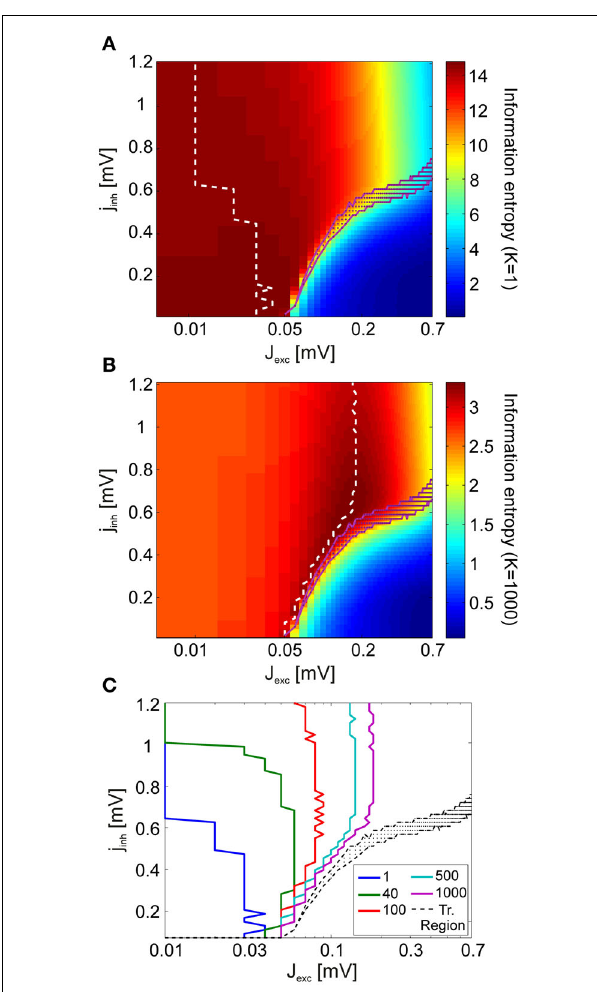
FIGURE 7 | Analysis of information entropy in V4 spike patterns. Information entropy in coupling space for the finest observation scale ( K = 1) (A) and the coarsest observation scale ( K = N = 1000) (B) averaged over all stimuli. In (A,B) , the dashed white lines indicate the entropy maxima for each value of the inhibitory coupling scaling factor j inh . The magenta dots mark the transition region. (C) The maxima of information entropy for different observation scales K . Entropy maxima converge toward the transition region (black) as K is